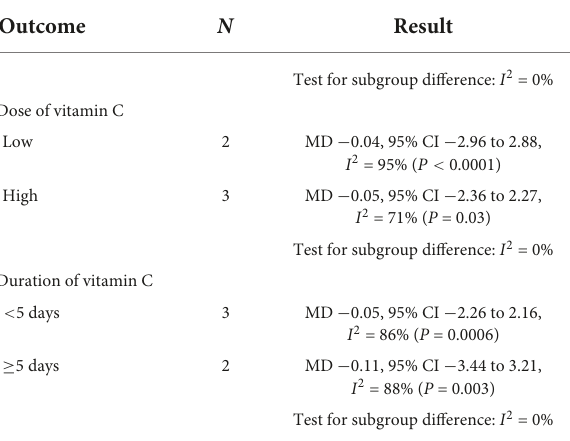
TABLE 2 Main findings and subgroup